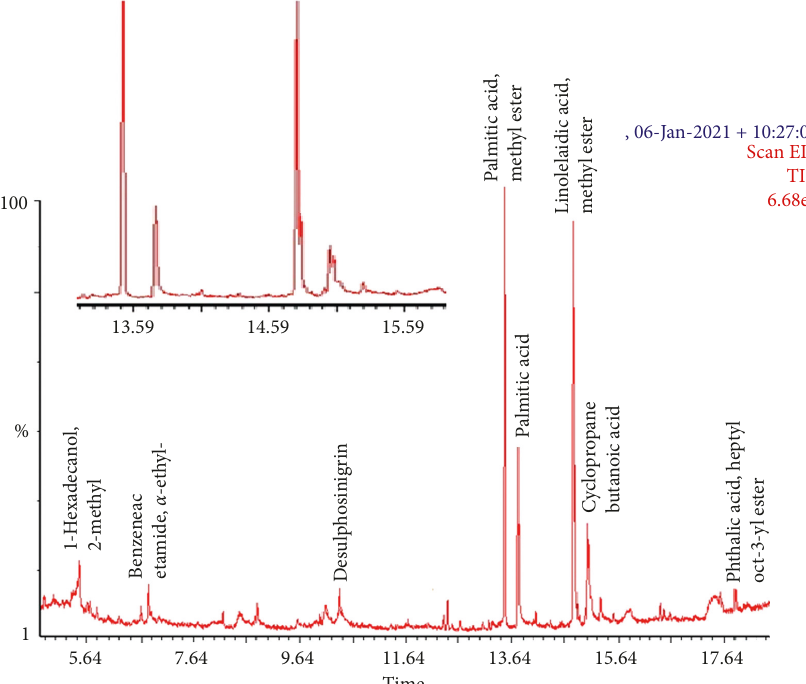
Figure 4: GC-FID chromatogram of aerial parts of essential oil of CSH � C. scolymus L. heart on HP-5MS column. The numbering of the identified peaks is given according to the serial number of compounds in Table